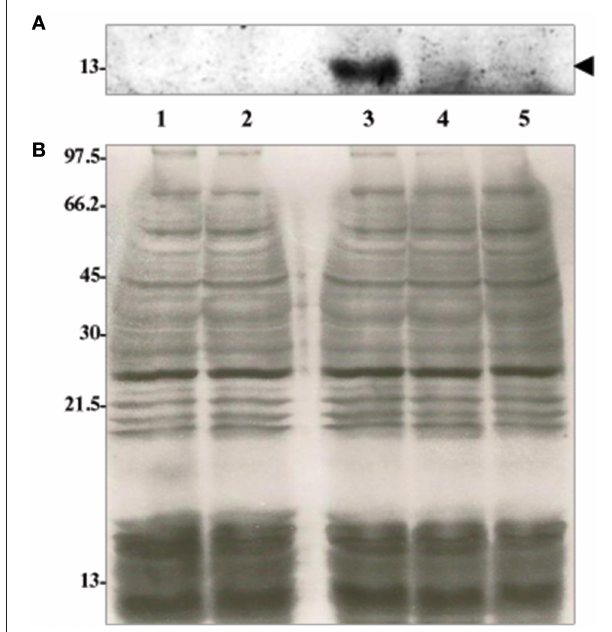
FIGURE 5 | In vitro coupled transcription-translation (IVTT) of C. burnetii ’s S23p. (A) 12.5% acrylamide [wt/vol] SDS-PAGE gel visualized by fluorescent scanning. A prominent ∼ 13-kDa protein band (arrow head) was identified in the IVTT reaction using S23p + RBS (Lane 3) but was absent in IVTT reactions using S23p_439 (Lane 4) and S23p_493 (Lane 5). (B) Corresponding silver-stained 12.5% acrylamide [wt/vol] SDS-PAGE showing